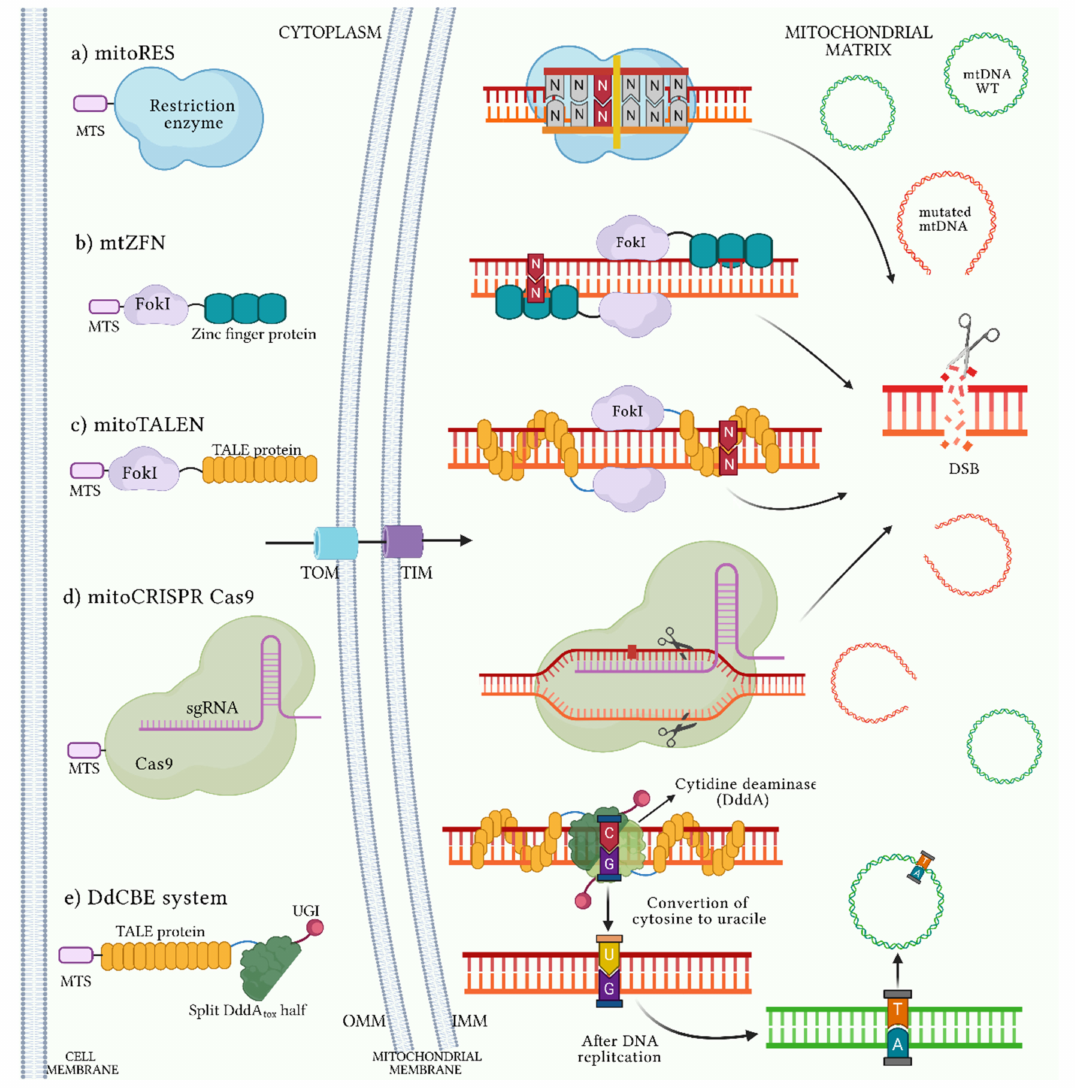
Figure 5. Heteroplasmic shifting strategies. The biological systems for modifying heteroplasmic levels of mtDNA mutations are presented. ( a ) mitoREs recognize specific sequences originated by acquired mtDNA mutations. ( b ) mtZFNs and ( c ) mitoTALENs can expand the recognition sequences for mtDNA mutations, resulting in more specificity. ( d ) The mi- toCRISPR Cas9 system uses sgRNA for the mutation recognition. mitoREs, mitoZFNs, mitoTALENs and CRISPRCas9 systems use their endonuclease activity to induce DSB, linearizing and degradation of mutated mtDNA. ( e ) The DdCBE system can mediate the C to U conversion of C–G base pairs. Given its dependence on mtDNA replication, the newly syn- thesized mtDNA molecule will have the T–A base pairs, thus modifying the levels of heteroplasmy. DdCBE: DddA-derived cytosine base editor; DSB: doble-strand break; IMM: inner mitochondrial membrane; mitoCRIPR/Cas9: mitochondrial clustered regularly interspaced short palindromic repeats/CRISPR associated protein 9; mitoREs: mitochondrial restriction endonucleases; mitoTALEN: mitochondrial transcription activator-type effector endonucleases; mitoZFN: mitochondrial zinc finger coupled endonucleases; MTS: mitochondrial target sequence; OMM: outer mitochondrial membrane; sgRNA: guide RNA; TIM: translocase of the inner membrane; TOM: translocase of the outer membrane; UGI: uracil glycosylase inhibitor. WT: wild-type. Figure artwork created with